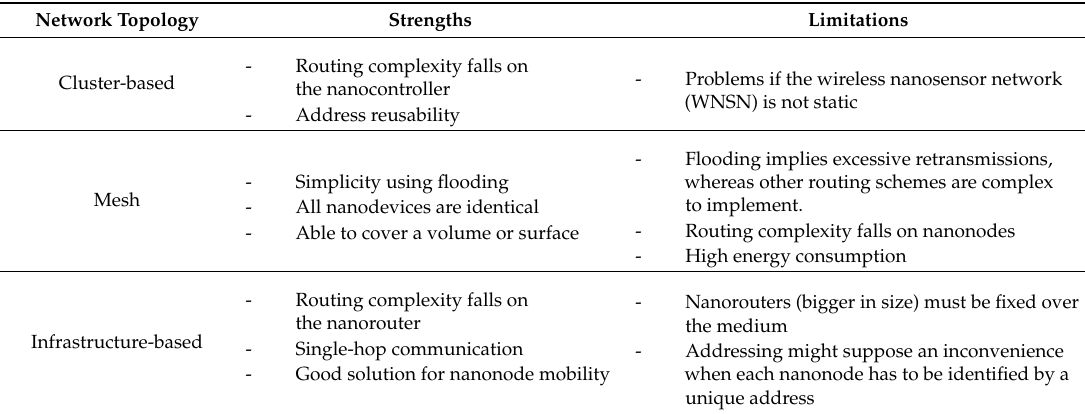
Table 1. Strengths and limitations for each network